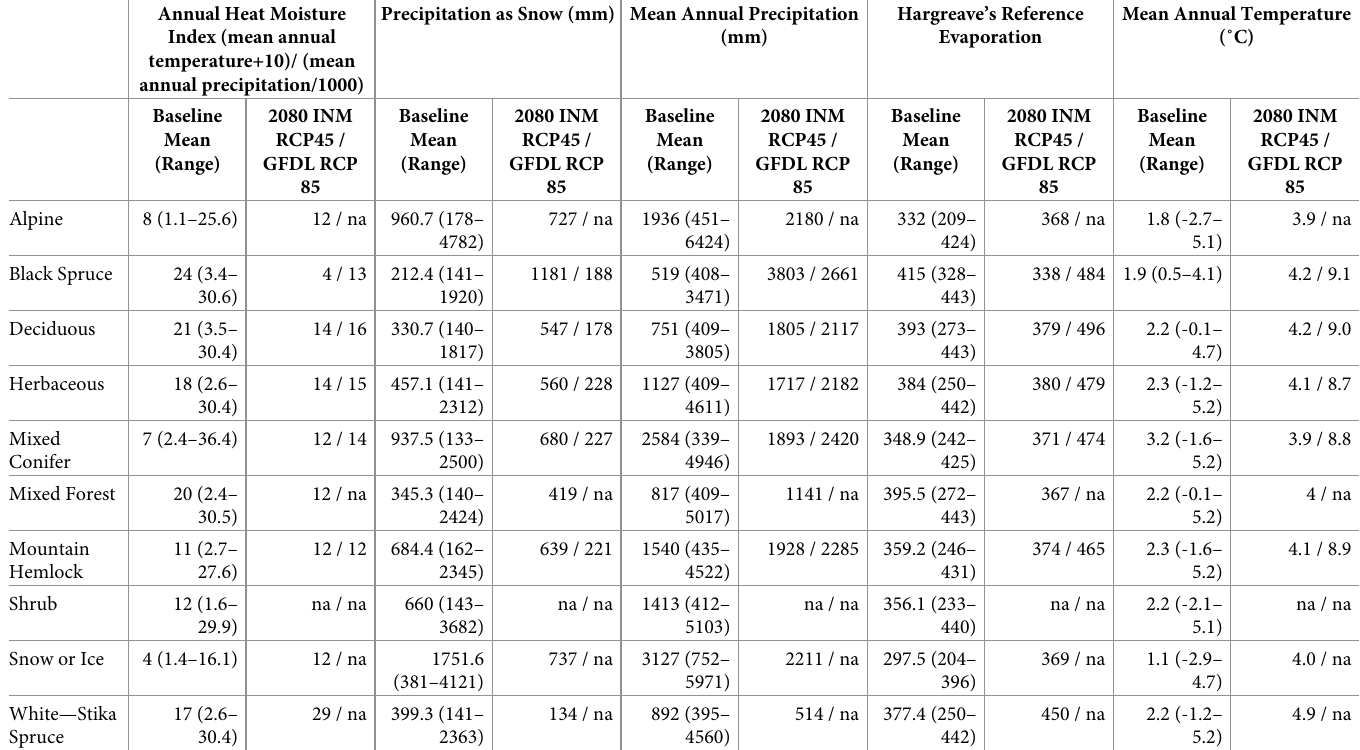
Table 5. Climate by vegetation. Mean and range of Adaptwest baseline (1960–1990) climate summarized by vegetation community for the Kenai Peninsula, Alaska. Per- cent change in climate variables by vegetation community in 2080 as compared to the 1960–1990 baseline. The 2080s values are the means for areas forecasted to be a vege- tation community under theINM-CM4 RCP (lowest exposure) and GFDL-CM3 RCP85 (highest exposure)